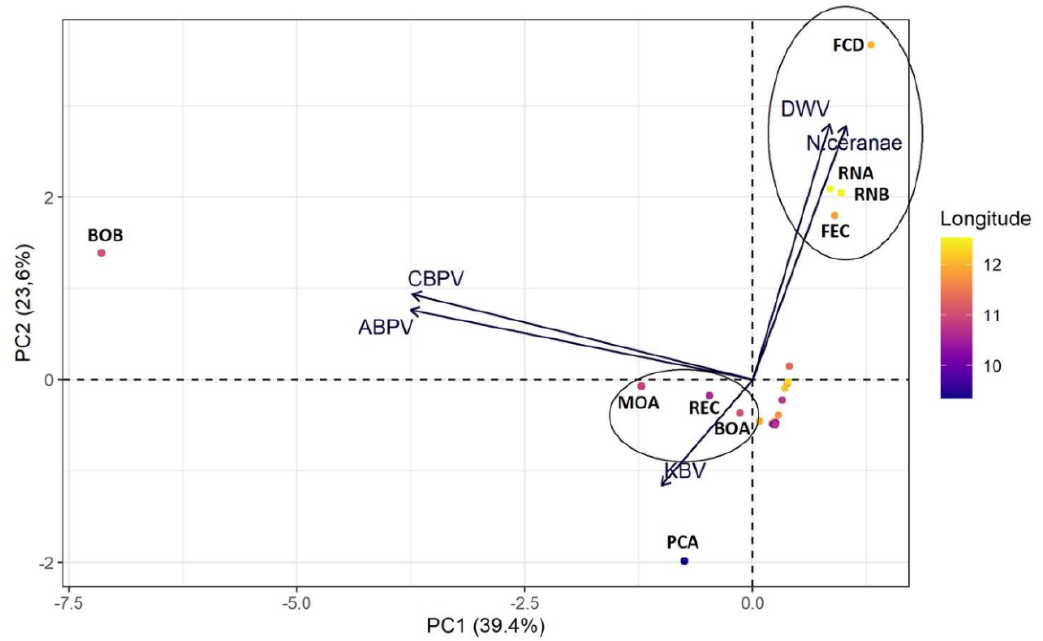
Figure 3. Graphical interpretation (biplot) of principal component analysis (PCA) on the abundance values of the considered pathogens for each apiary. The longitude is shown by different colours: bright and dark shades correspond, respectively, to apiaries closer to the coast (east) and the inland (west). Table 3. Relationship between Principal Components (PC1 and PC2) and pathogen abundance variables.